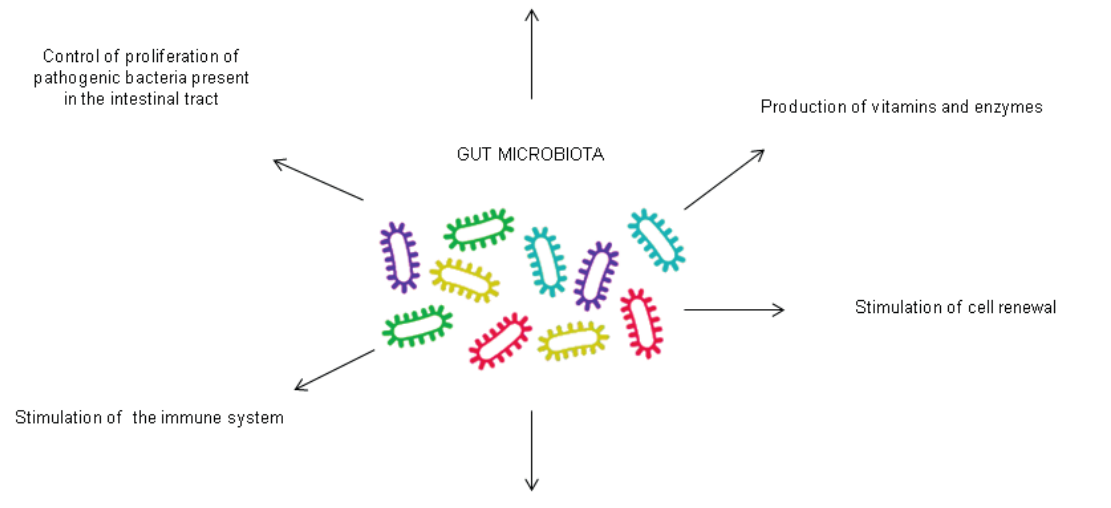
Fig. 1. Role of gut microbiota in humans. Human gut microbiota plays roles: stimulates the immune systém and cell reneval, produces vitamins and enzymes (such as vitamin K and biotin), enhances the synthesis of compounds useful for the trophism of colonic mucosa, and regulates the absorption of nutrients. One of its most important functions, however, is to regulate and influence the host’s metabolism and to control the proliferation of pathogenic bacteria found in the gastrointestinal tract (such as Clostridia or